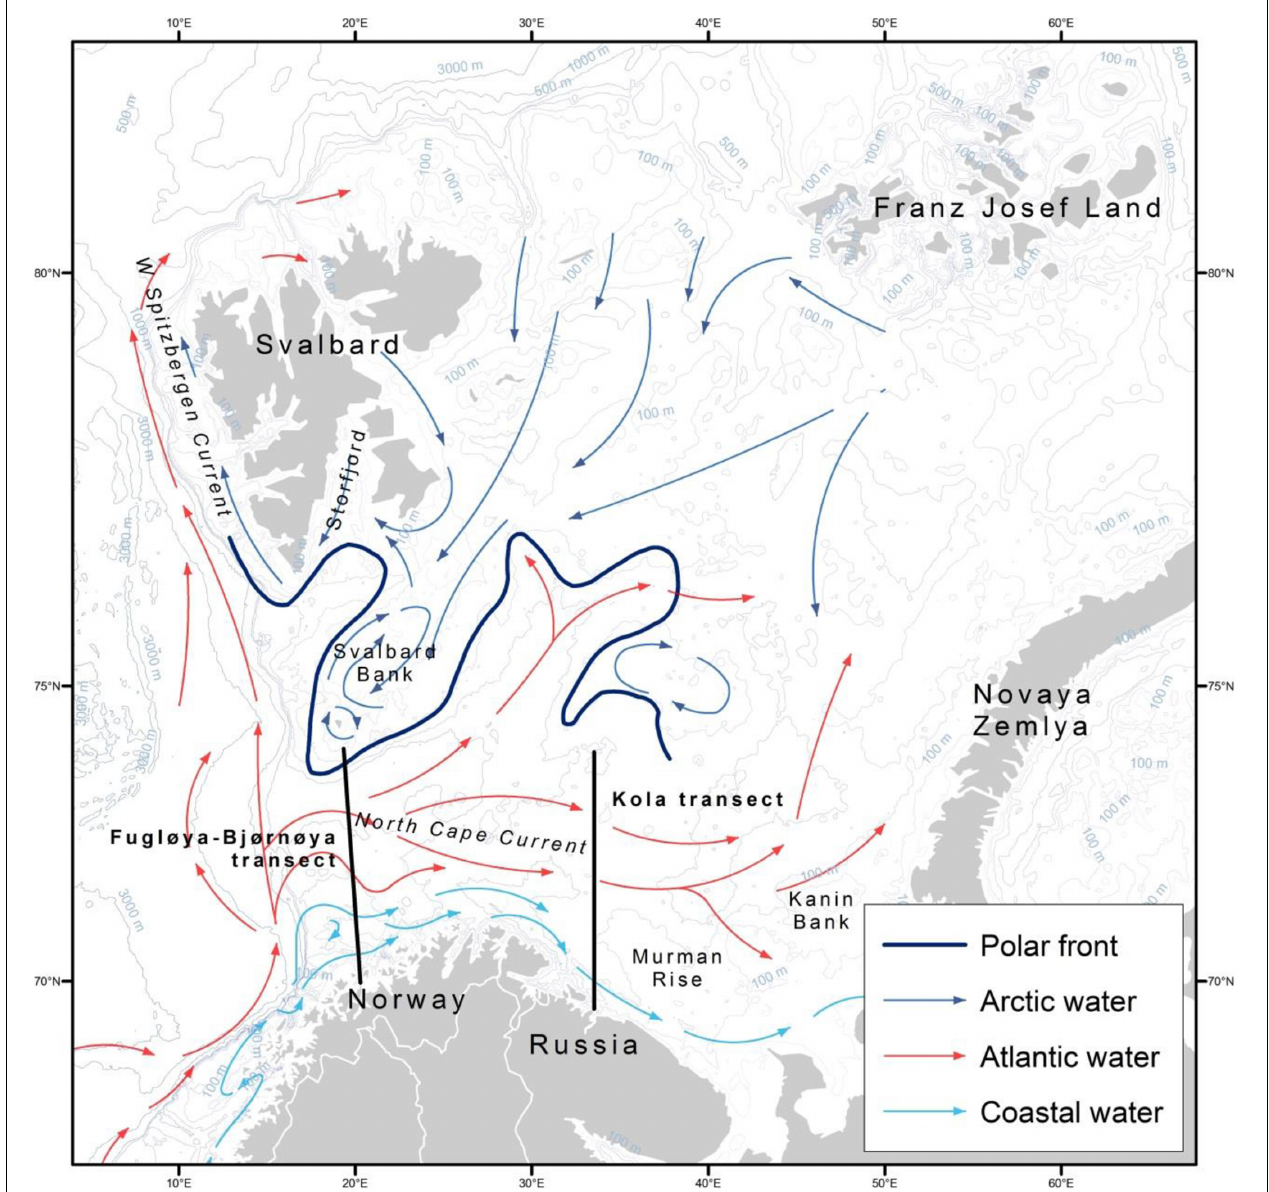
FIGURE 1 | Map of the Barents Sea region with main currents and places of interest labeled. Modified, with permission, from Stiansen and Filin (2007).